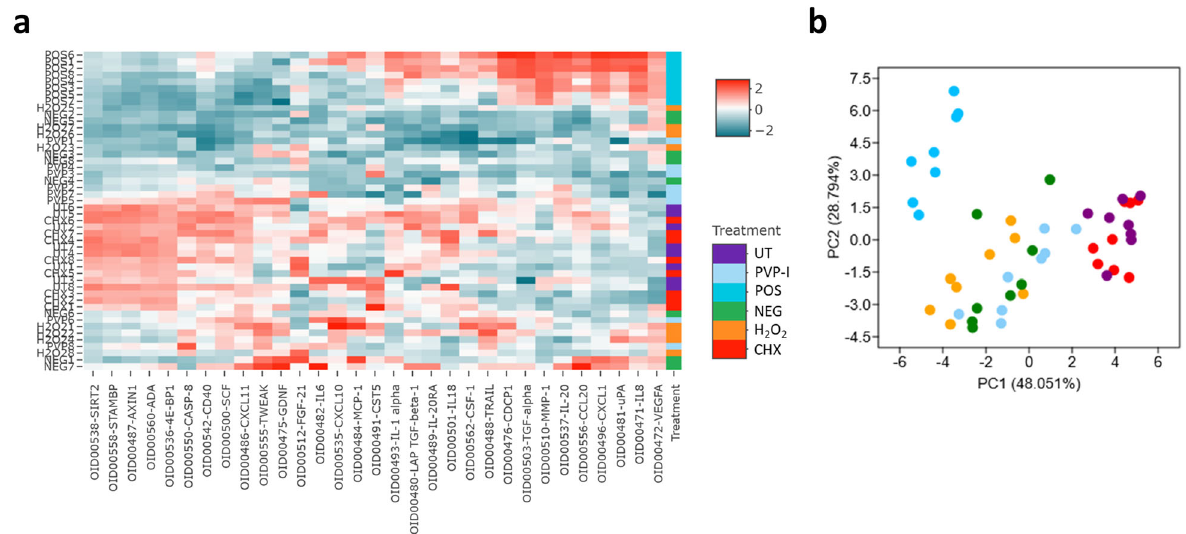
Fig. 5 Bio fi lm treatment dictates the proteomic pro fi le of the RHE tissue following co-culture. Hierarchical clustering of the proteomic response in the skin epidermis is depicted in panel a . For this analysis, all assay distributions in the data were centred around using NPX values for each protein, as detected using Olink technology. In brief, red bars indicate increased levels of proteins, with blue bars showing decreased levels of a given protein. A principal component analysis plot is shown in panel b , highlighting the unique clustering of the PMA-stimulated samples across both PC1 and PC2, with distinguishable clusters of the untreated and CHX-treated bio fi lms-stimulated tissue samples on